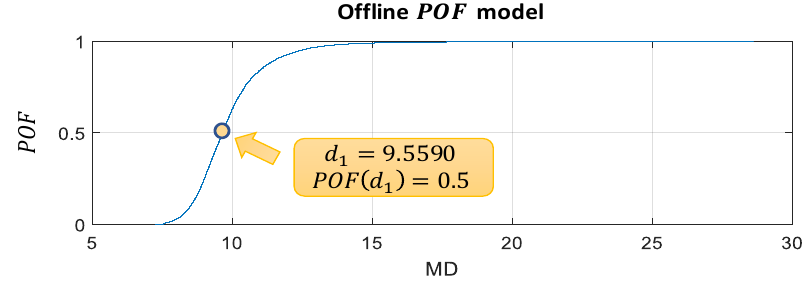
Figure 15. Offline 𝑃𝑂𝐹 model for case 2.